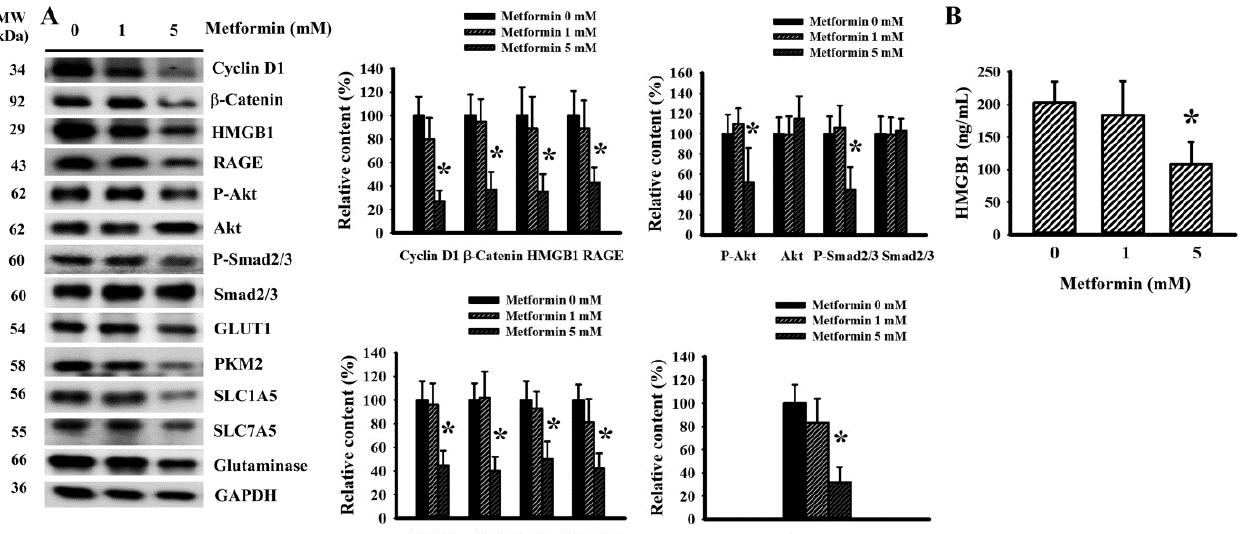
Figure 7. Metformin mitigated circulating parameters of NETs in obese mice. ND-fed lean and HFD-fed obese mice were subcutaneously inoculated with LLC cells over a course of three weeks. Three days after cell implantation, ND-fed lean mice were daily treated with saline vehicle